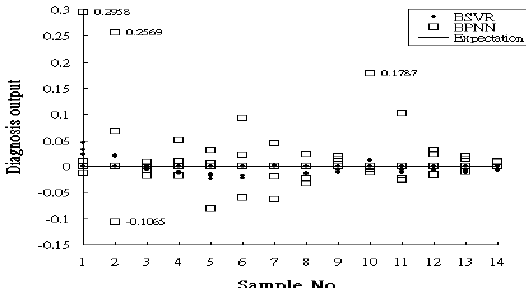
Figure 6. BSVR and BPNN output of non − detection.